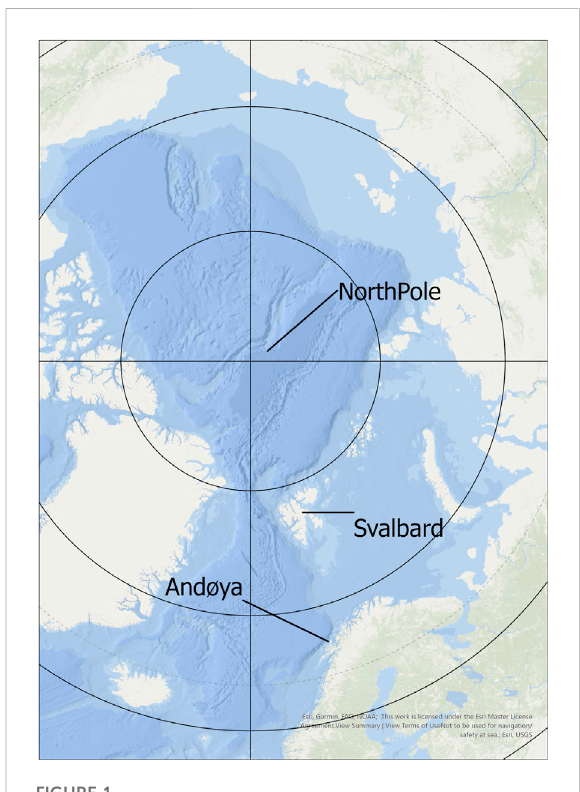
FIGURE 1 Map of the Arctic area, with Svalbard and Andøya marked. Map created by Jani Causevic, NIKU, 2022.